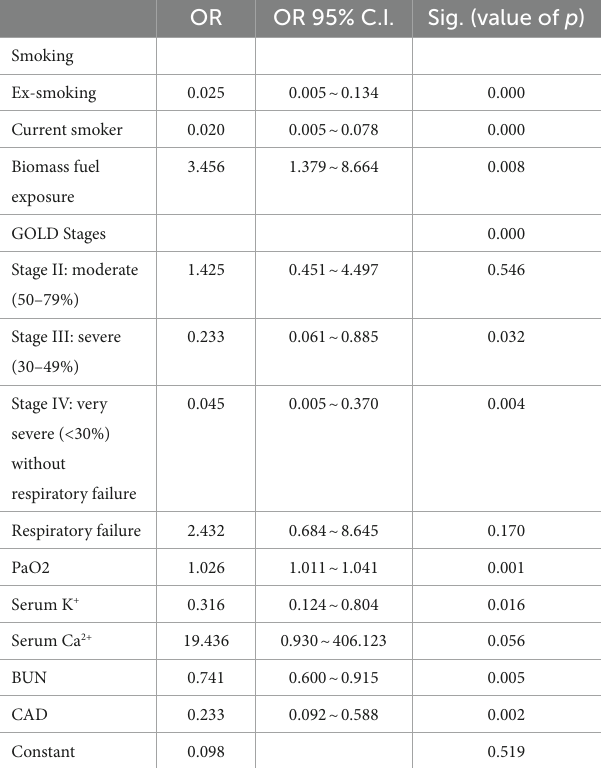
OR OR 95% C.I. Sig. (value of p